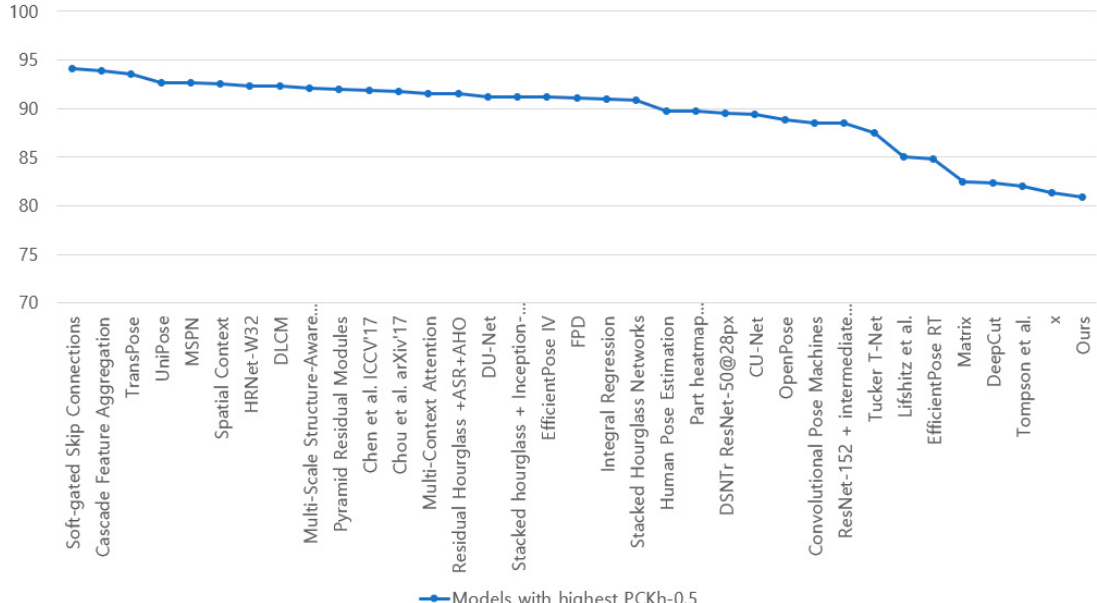
Table 2. The difference between human pose estimation methods.